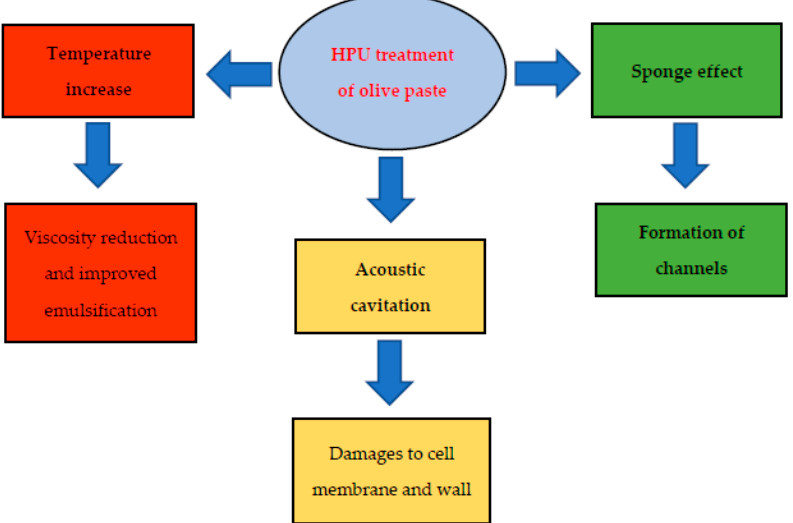
Figure 2. The main effects of olive paste HPU treatment contributing to improve oil